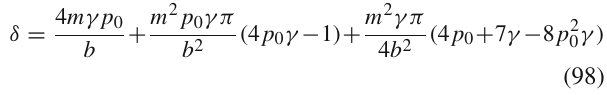
Fig. 16 The graphs show the variation in the redshift z versus r charged ( q (cid:8)= 0 ) and static uncharged ( q = 0 ) cases. Variation for each case are shown on the same graph for different values of deformation parameter